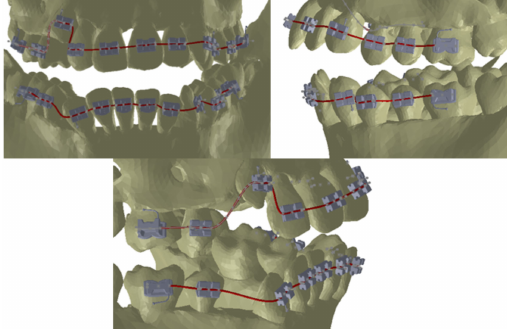
Figure 20. Model of the orthodontic system.